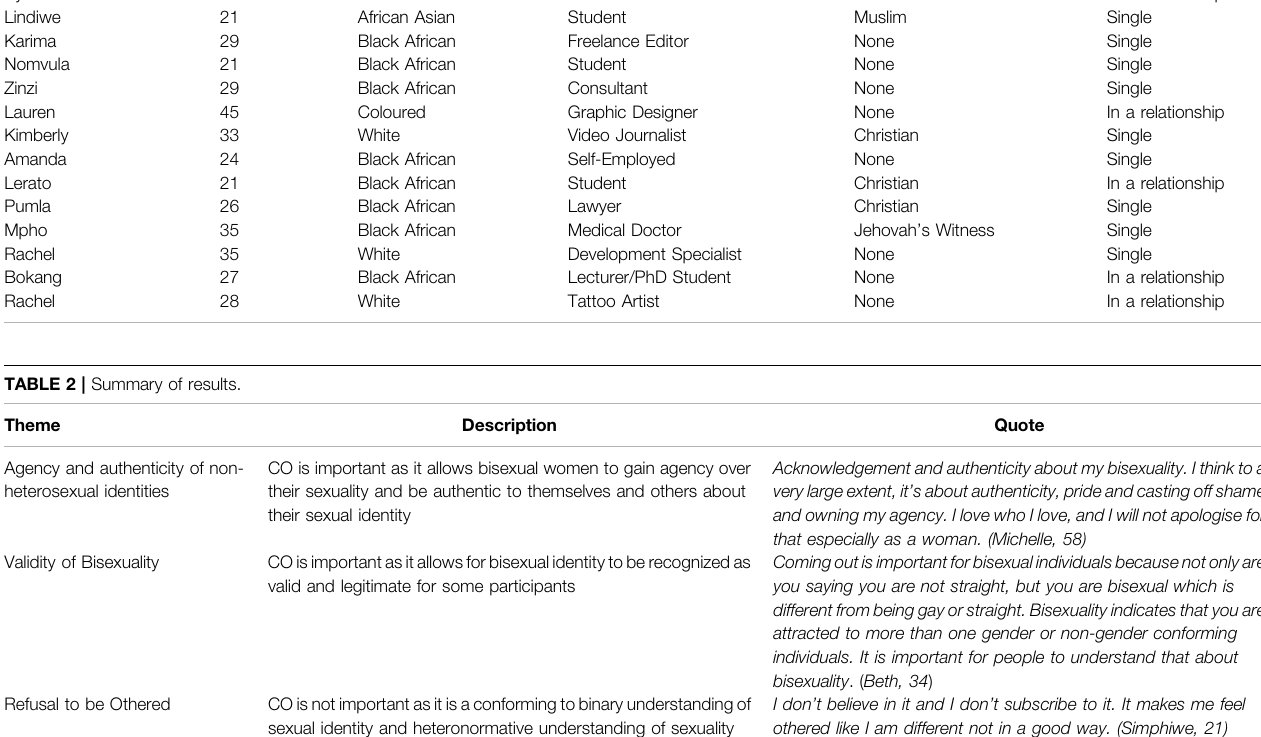
In a relationship